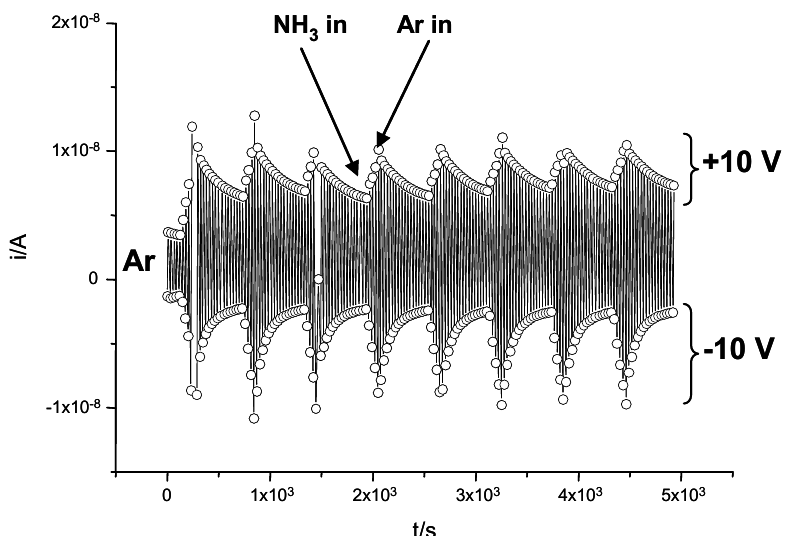
Pc)|Al heterojunction sample after being Figure 6. Steady current and reversibility of Au|NiPc|Ni(F 16 submitted to cycles NH /Ar in dynamic rest (2 min/8 3